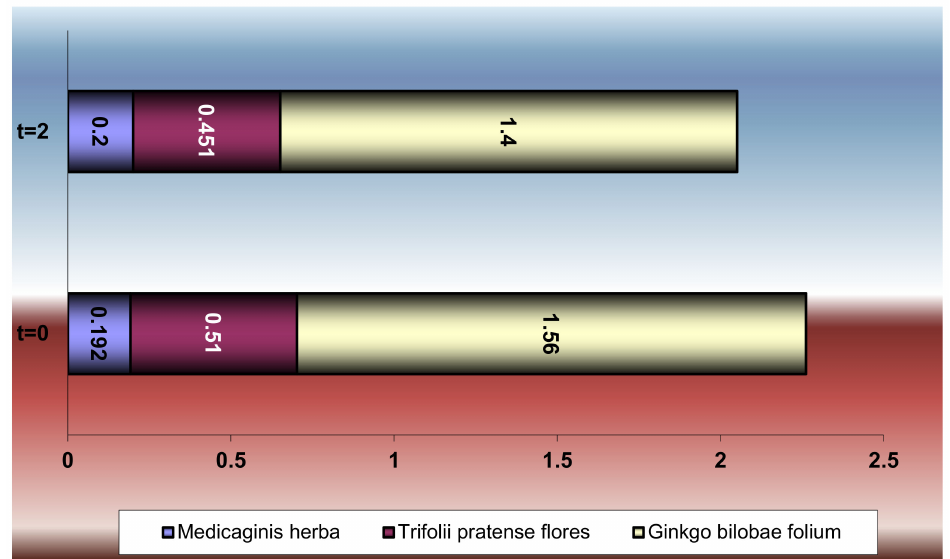
Figure 5. Graphical representation of the antioxidant capacity of hydroalcoholic solutions of Med- icaginis herba, Trifolii pratensae flores, and Ginkgo bilobae folium .